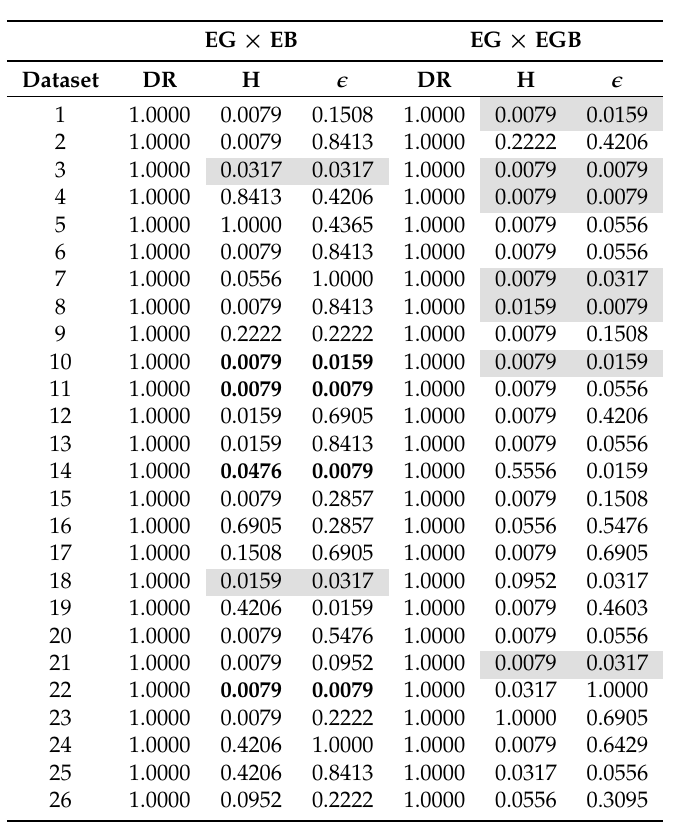
Table 4. MAGMA multi-objective